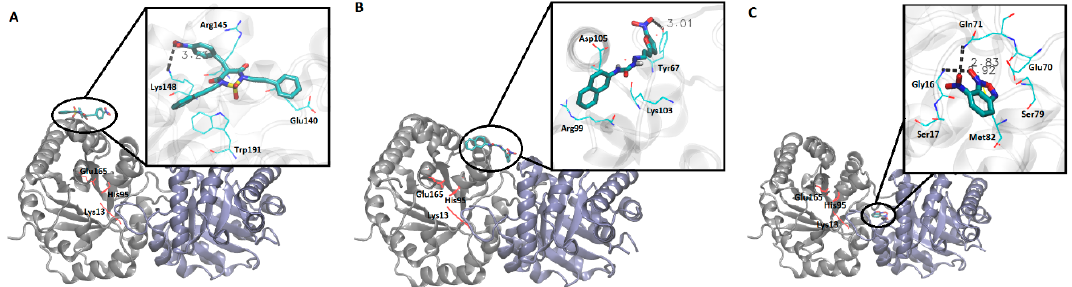
Figure 4. Molecular docking studies for compounds 50 , 98 , and 14 . Graphic representation of the interaction between each inhibitor with Rm TIM. ( A ) Compound 50 , amino acids from the active site are depicted in red. The zoom in the inset shows ligand–enzyme interactions at the binding site. ( B ) Compound 98 , amino acids from the active site are depicted in red. The zoom in the inset shows ligand–enzyme interactions at the binding site. ( C ) Compound 14 , amino acids from the active site are depicted in red. The zoom in the inset shows ligand–enzyme interactions at the binding site.